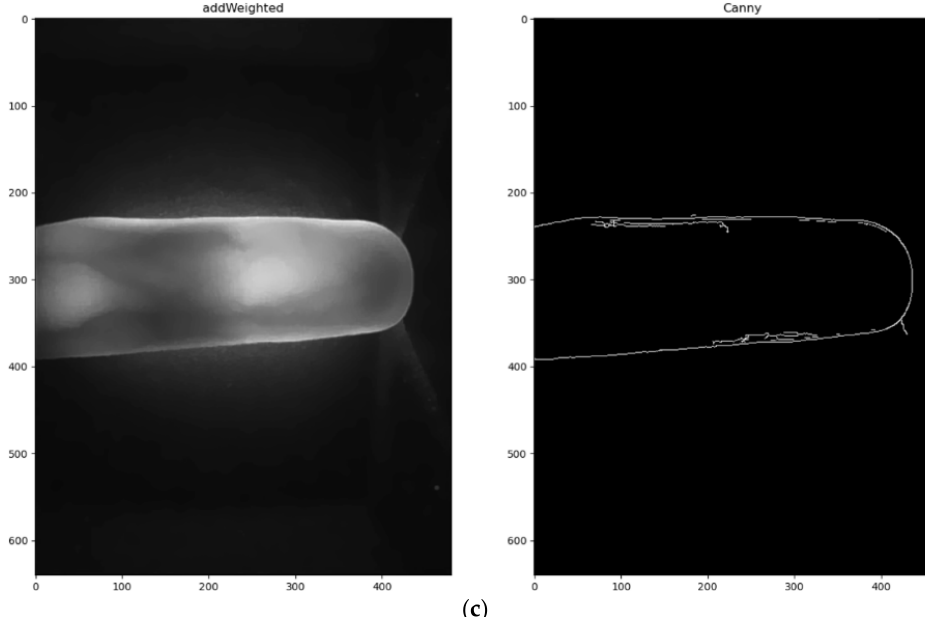
Figure 3. The multi ‐ layer edge detection method: ( a ) Bilateral image after Sobel operator processing; ( b ) Using ( a ) gives the pixel add weighting result; ( c ) Using ( b ) with the Canny operator.